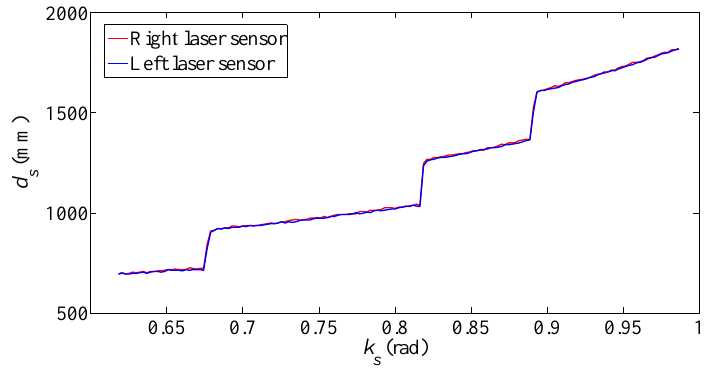
Figure 9. Distance measured during the scanning on the staircase surface before climbing down.